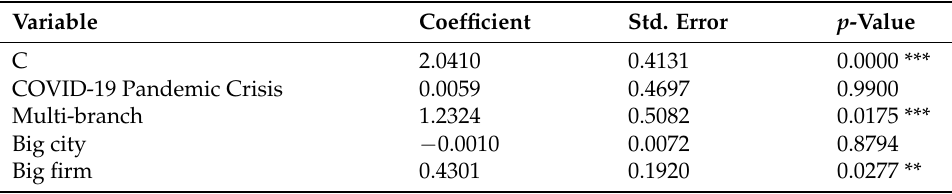
Table 2. The results of the first research model.